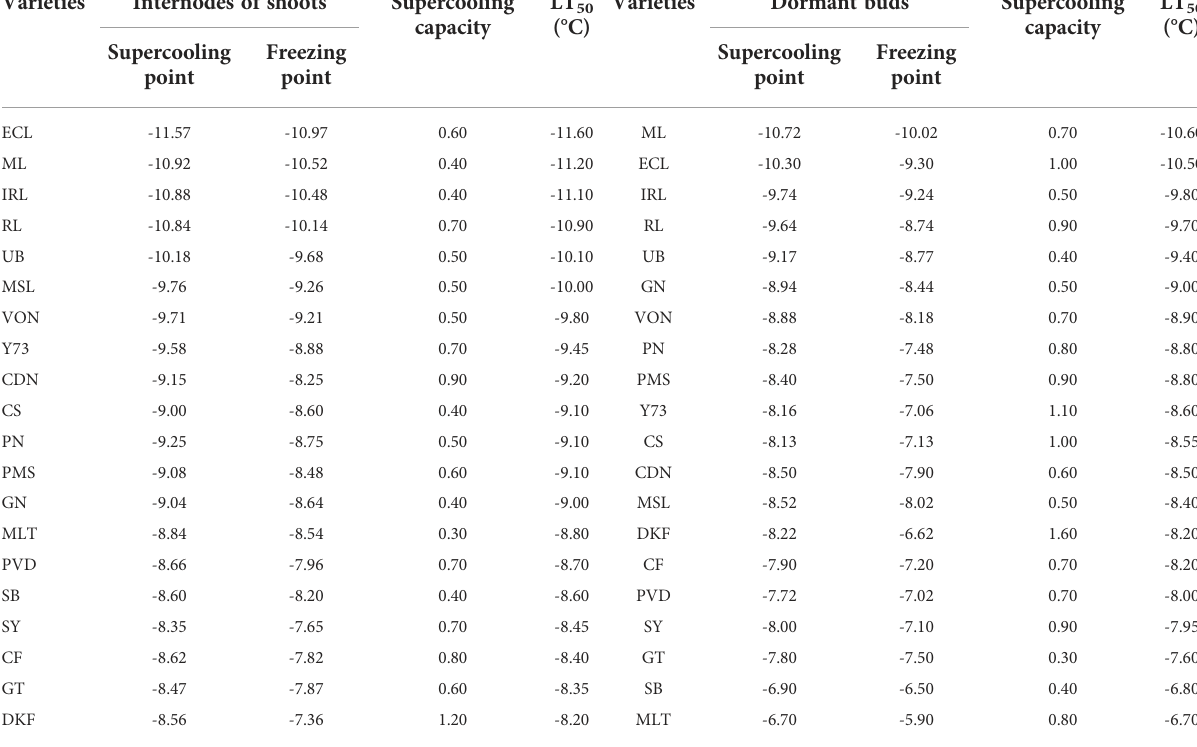
TABLE 2 Identi fi cation of cold resistance in 20 wine grape varieties based on DTA.